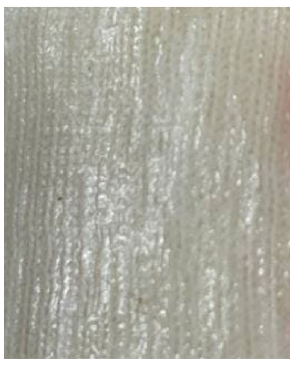
Figure 6. Internal surface of TF socket with 2:3 epoxy resin to hardener